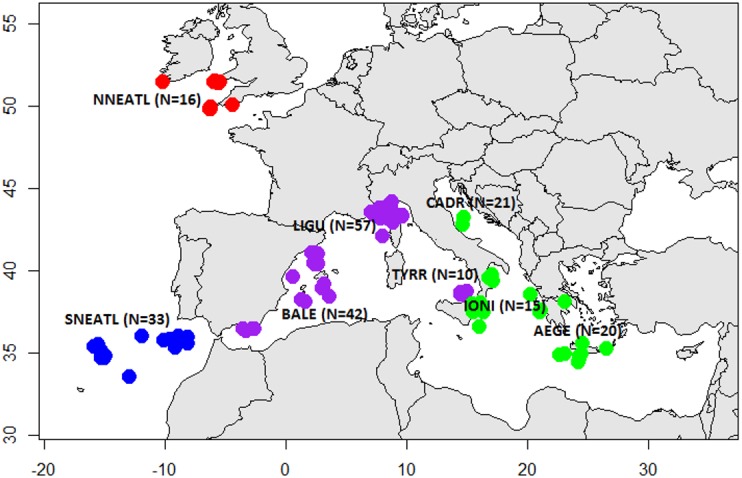
Sampling sites of Mediterranean and North Eastern Atlantic Blue Sharks.North North-Eastern Atlantic (NNEATL, red dots, N = 16), South North-Eastern Atlantic (SNEATL, blue dots, N = 33), Western Mediterranean (WMED, purple dots, N = 109) and Eastern Mediterranean (EMED, green dots, N = 56). The map was created using R version 3.4.1 (R Core Team, 2016; Becker, Wilks & Brownrigg, 2017).